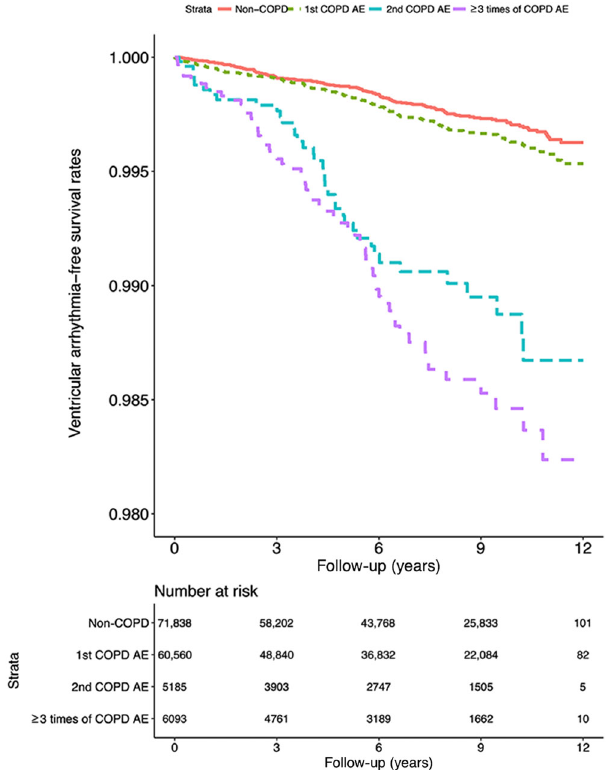
Fig. 3 VA admission events in the study cohort (n = 143676) from January 1, 2001 to December 31, 2012 in Taiwan. Data were strati fi ed by the frequency of COPD acute exacerbations (log-rank test, χ 2 = 198.964; df = 3; p < 0.001).